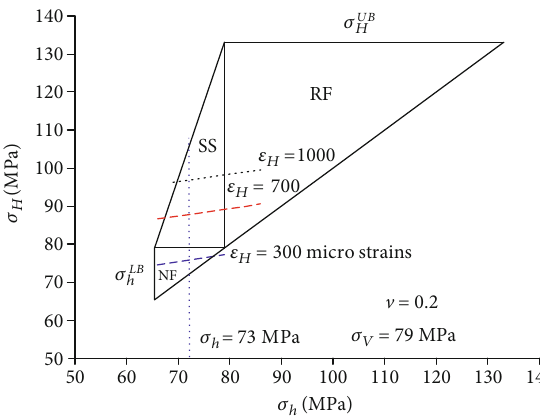
Figure 8: Wellbore breakouts and drilling-induced tensile fractures occurred simultaneously in a vertical borehole.